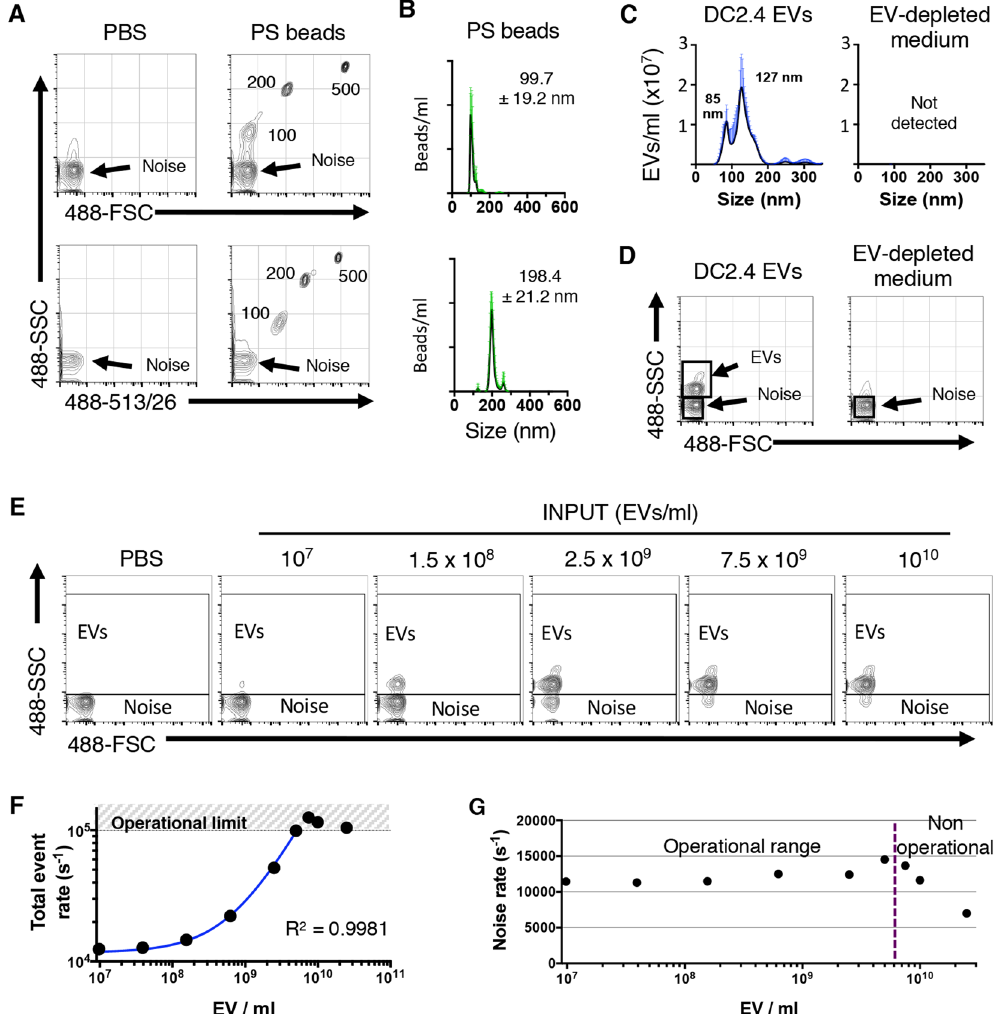
Figure 2. Submicron particle detection by nanoFACS HR-FCM. ( A ) Representative dot plot of PBS or 100, 200 and 500 nm polystyrene beads, analyzed by light scattering and fluorescence by nanoFACS, with background reference noise shown in the lower left corner in each plot. The background reference noise is a random sampling of scattered light from laser:stream intercept. ( B ) Size distribution of 100 and 200 nm polystyrene beads and ( C ) DC2.4-derived EVs (left) or control sample from EV-depleted medium subjected to same isolation procedure (right) by NTA. ( D ) DC2.4 EV detection by light scattering in nanoFACS, clearly resolved above the background reference noise. ( E ) Serially diluted DC2.4 EV analisis by nanoFACS to assess the suitable operational range that avoids coincident detection of particles. The relative percentage of noise and EVs particles changes as the EV concentration increases, but the light scattering pattern doesn’t change. ( F ) Quantification of the total event rate in E . Dotted line depicts the limit of the operational range. The curve fit was calculated by nonlinear regression excluding the three most concentrated EV preparations. ( G ) Noise rate is stable in the operational range, but drops when sample concentration is above the operational range (gate strategy shown in E ). Representative data from multiple independent experiments with similar results. NTA histograms represent the mean of three independent acquisitions ± SD in green. The numbers on the NTA graphs indicate the mode value of the size. EV, extracellular vesicle; Noise, background reference noise; FSC, forward and SSC, side light scatter; NTA, Nanoparticle Tracking Analyses; SD, standard